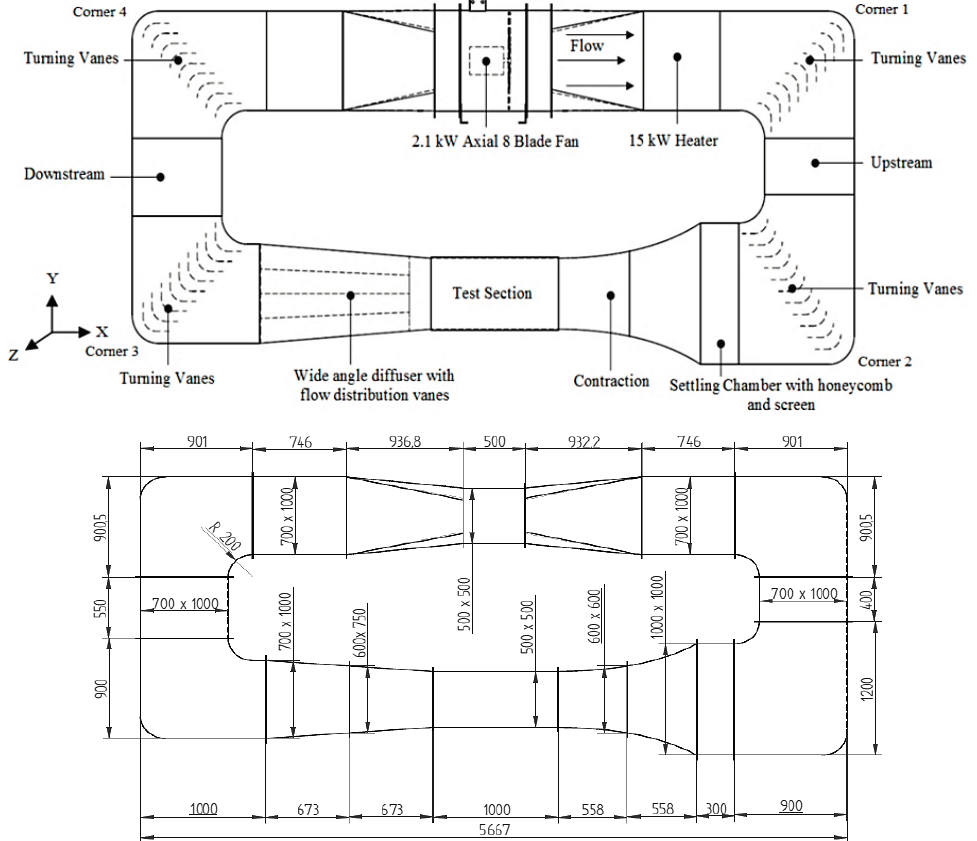
Figure 1. Schematic representation of the wind tunnel